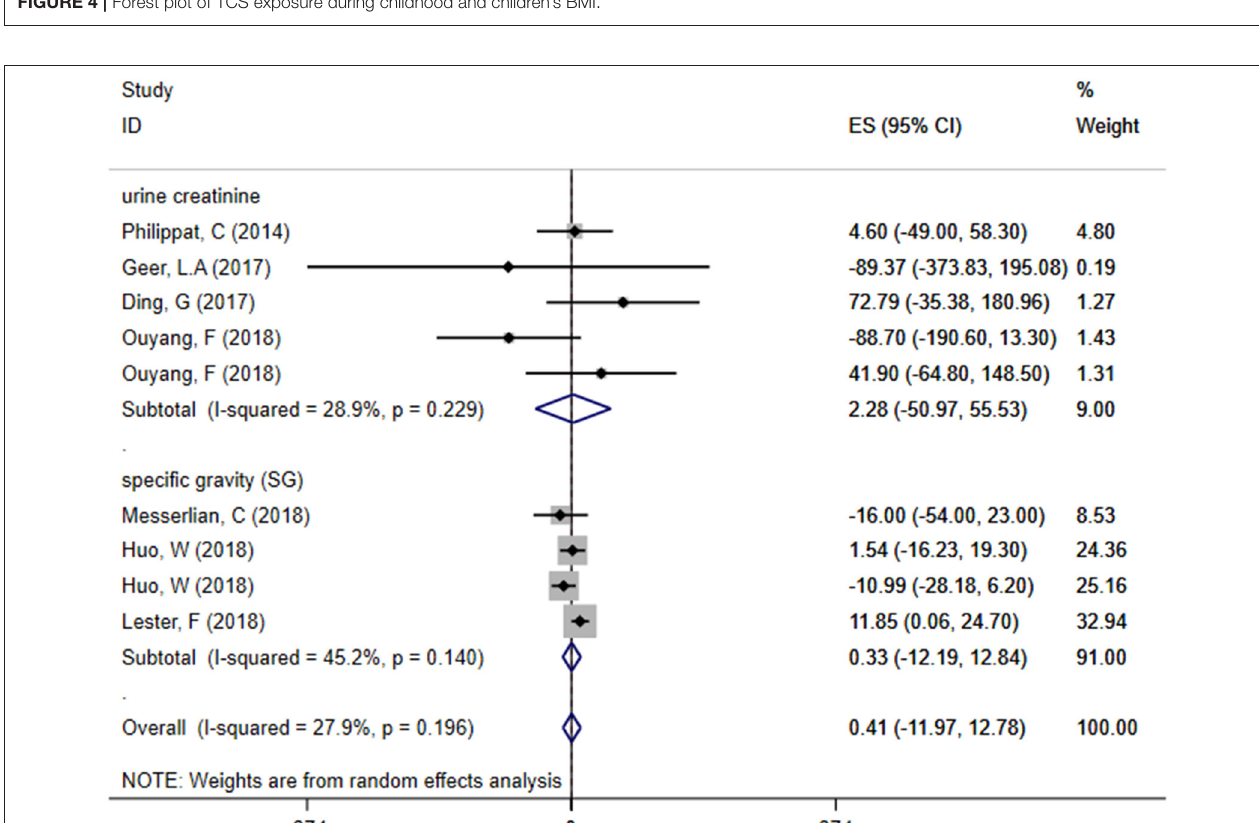
FIGURE 4 | Forest plot of TCS exposure during childhood and children’s BMI.